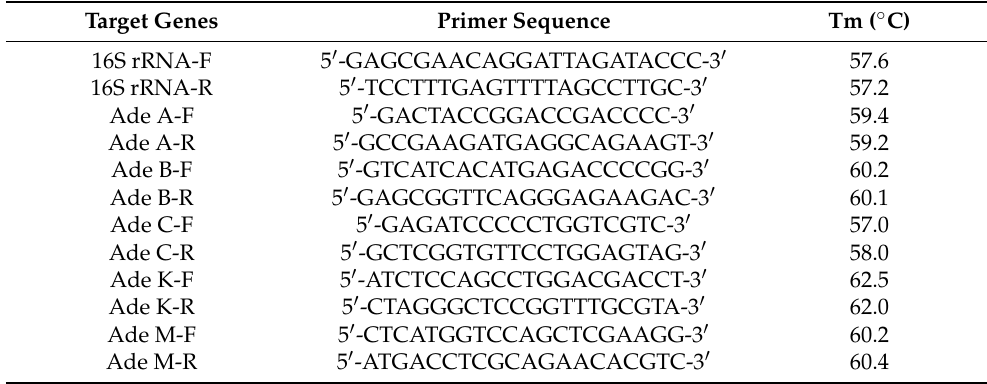
Table 2. Primers used for RT-qPCR